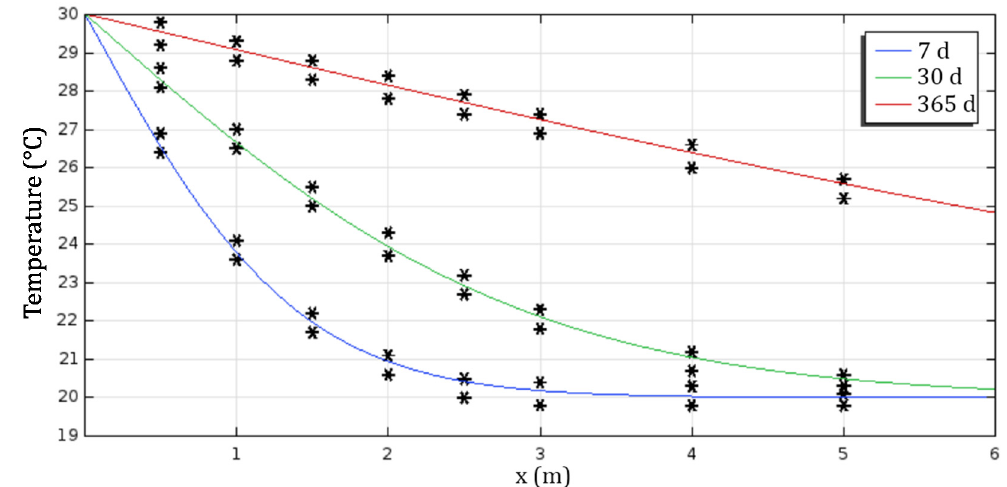
Figure 2. Comparison of the temperature profiles obtained numerically (continuous lines) with those of the EN 15026 standard (asterisks).